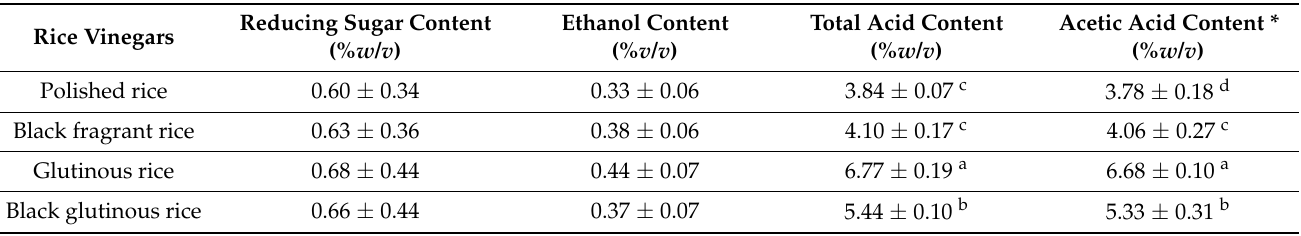
Table 2. Reducing sugar, ethanol, total acid and acetic acid contents in Thai rice vinegars in 32th day of fermentation at room